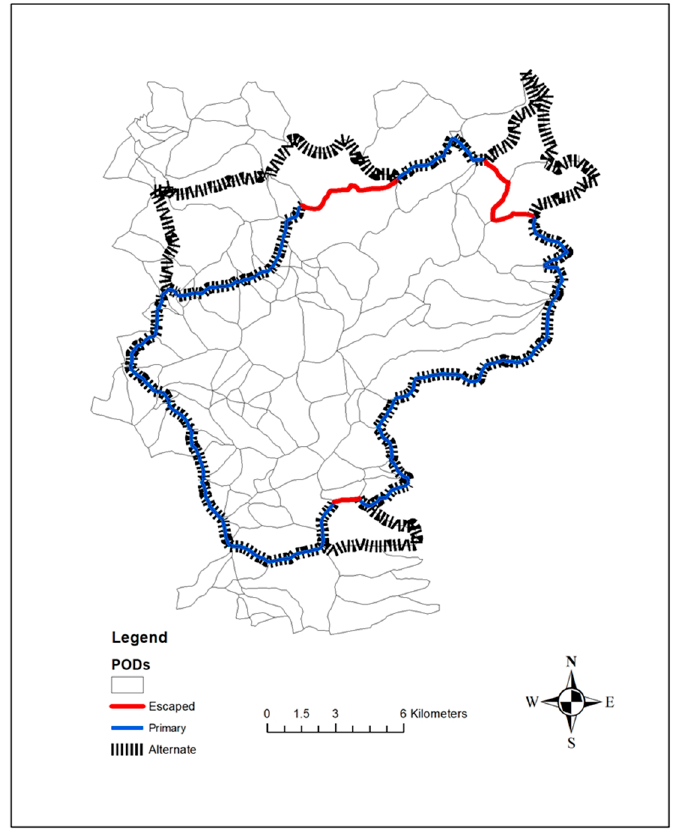
Figure 7. Development of contingency strategy for test scenario B after some POD boundaries associated with the primary strategy were breached.